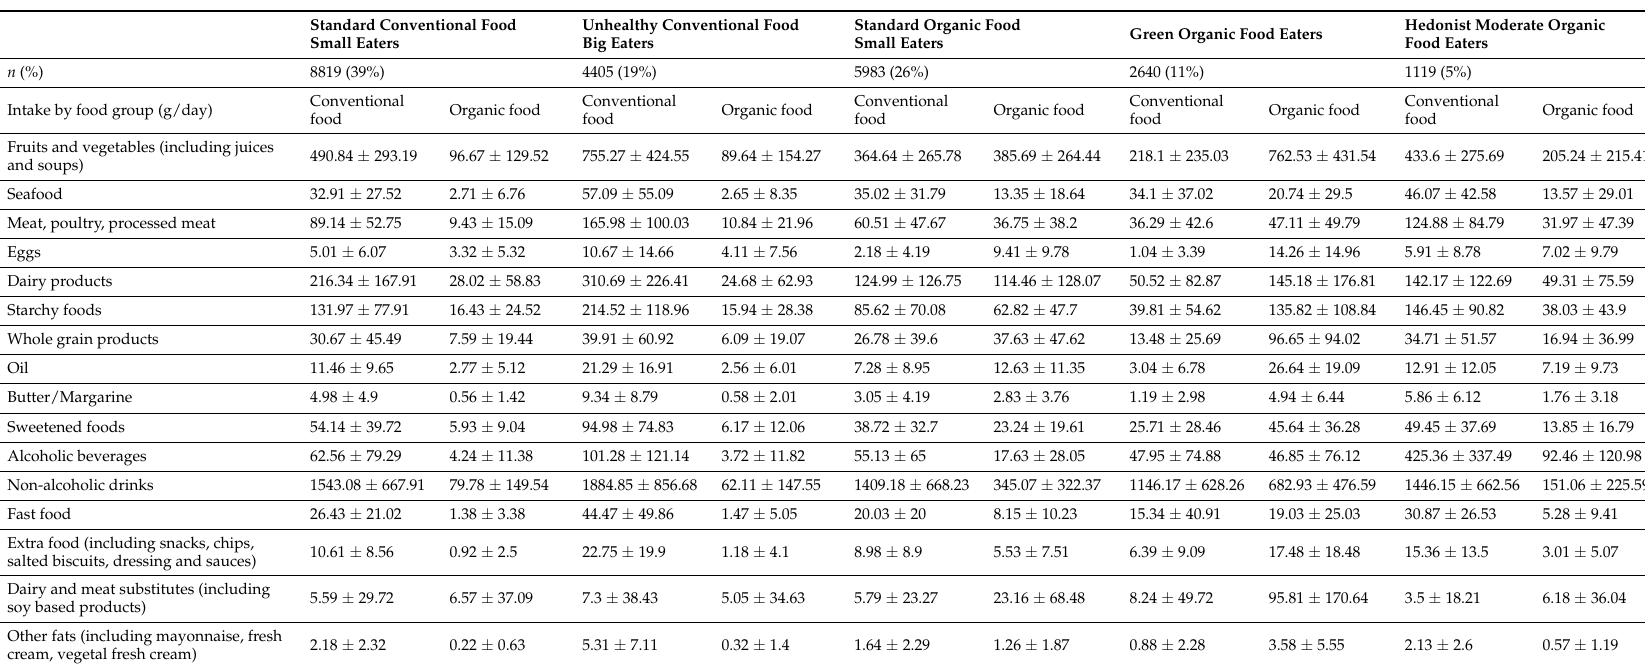
Table 3. Mean values of the 32 variables (16 × 2 food group consumption) in grams per day included in the principal component analysis across clusters, NutriNet-Santé Study, n = 22,966 1